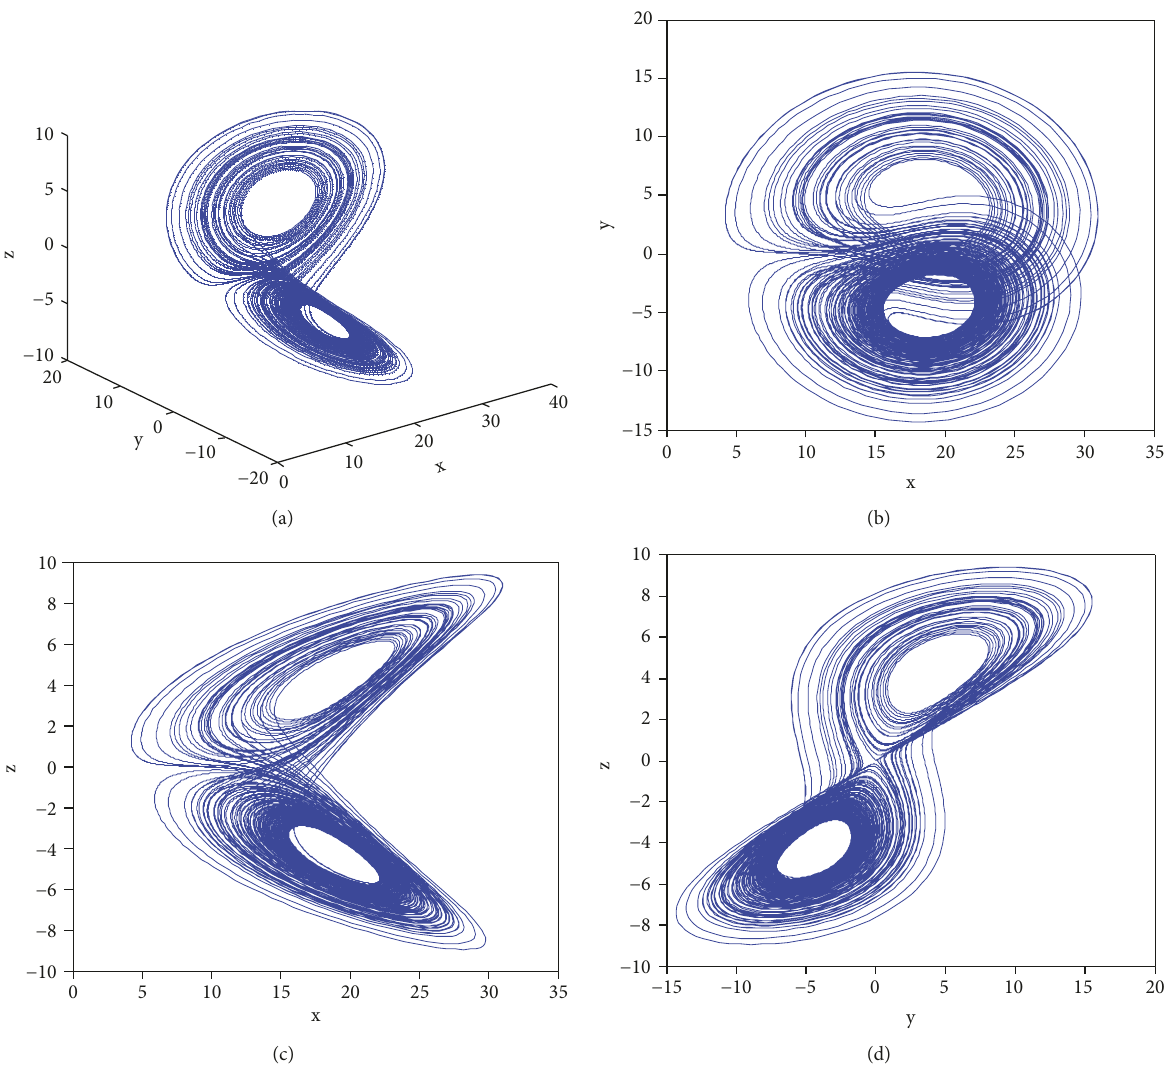
Figure 1: The 3D and 2D projections of system (1) with a , b = 28, 3 in the (a) x − y − z space, (b) x − y plane, (c) x − z plane, and (d) y − z plane,